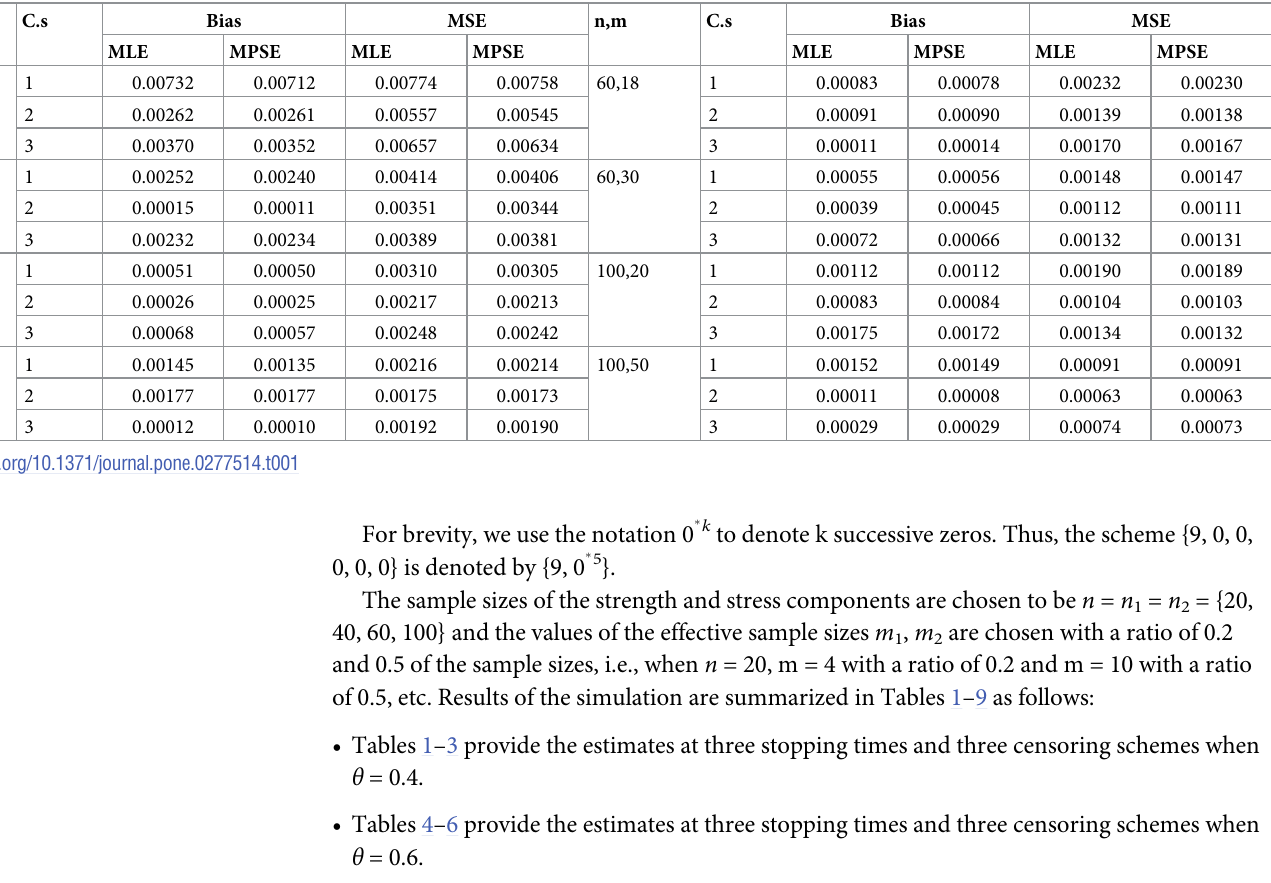
Table 2. Bias and MSE of θ with T